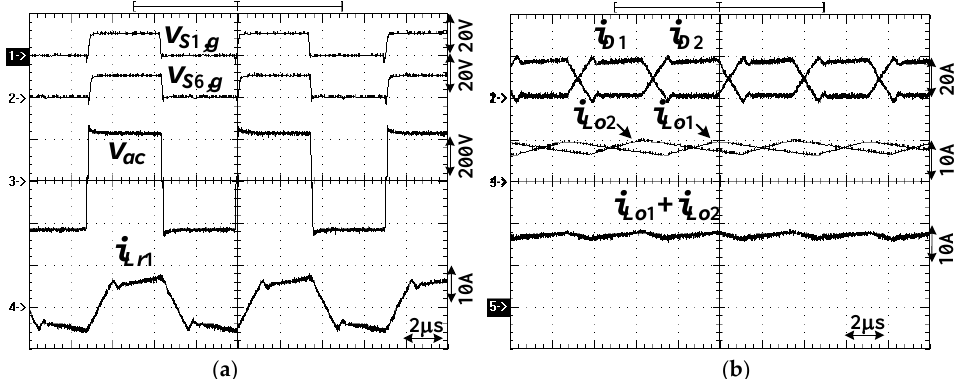
Figure 10. Test waveforms at V in = 250 V and P o = 800 W: ( a ) primary-side waveforms v S 1 ,g , v S 5 ,g , v ac , and i Lr 1 ; ( b ) secondary-side waveforms i D 1 , i D 2 , i Lo 1 , i Lo 2 , and i Lo 1 + i Lo 2 .